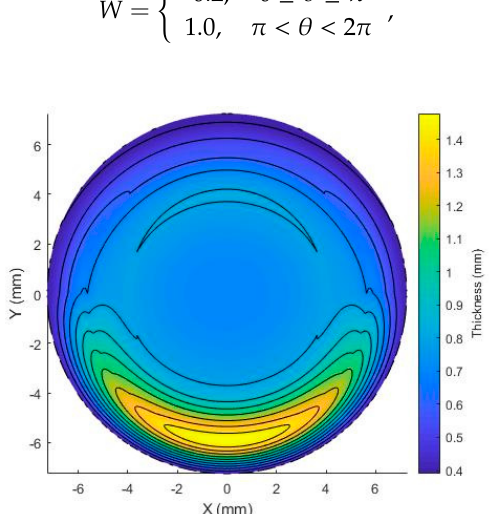
Figure 5. Graphical representation of the variation in lens thickness due to the inclusion of a single ballast.